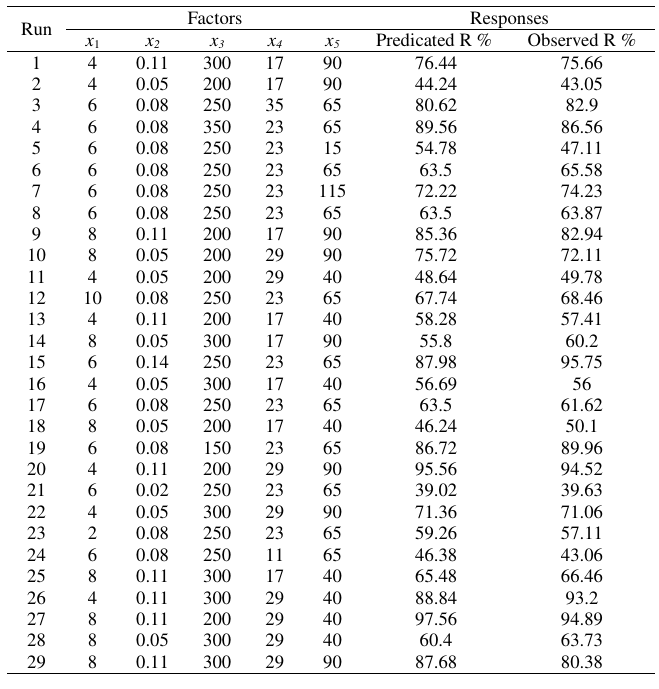
Table 5. Matrix of experimental design, experimental response and model predicted values.